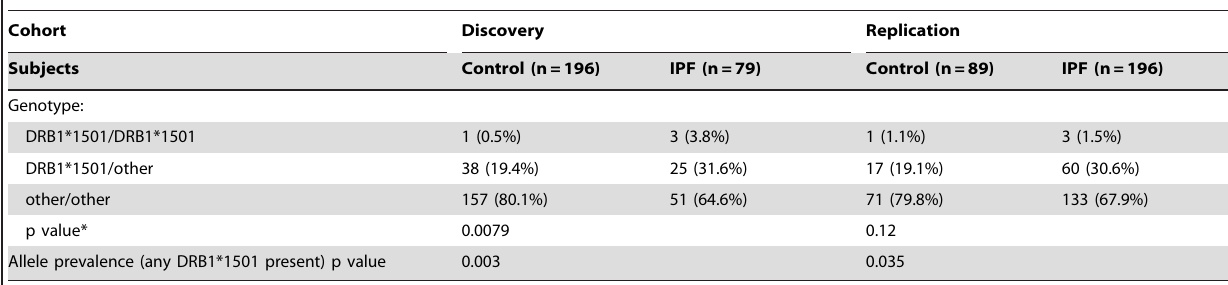
Table 3. Genotype distribution of